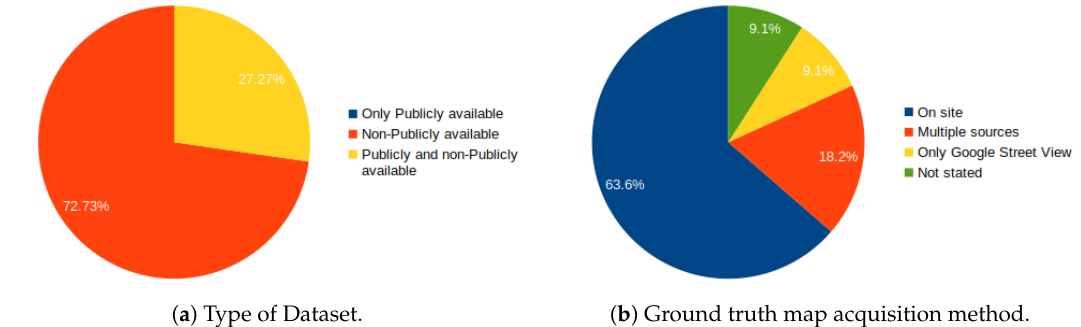
Figure 8. Dataset: type, ground truth map acquisition source.